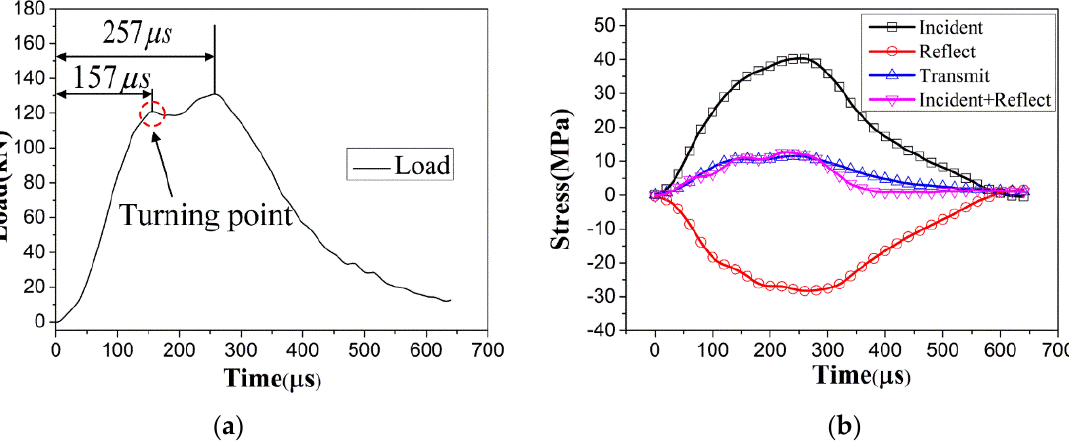
Figure 4. Load–time curve with a turning point. ( a ) Load–time curve, ( b ) equilibrium of stress.